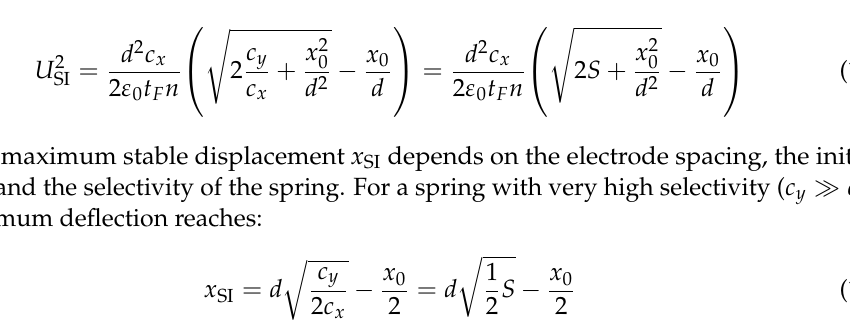
Figure 6. ( a ) Microscopic image of a characterized comb-drive actuator with a triangular spring, ( b ) characterization result comparing the displacement of comb-drive actuators.